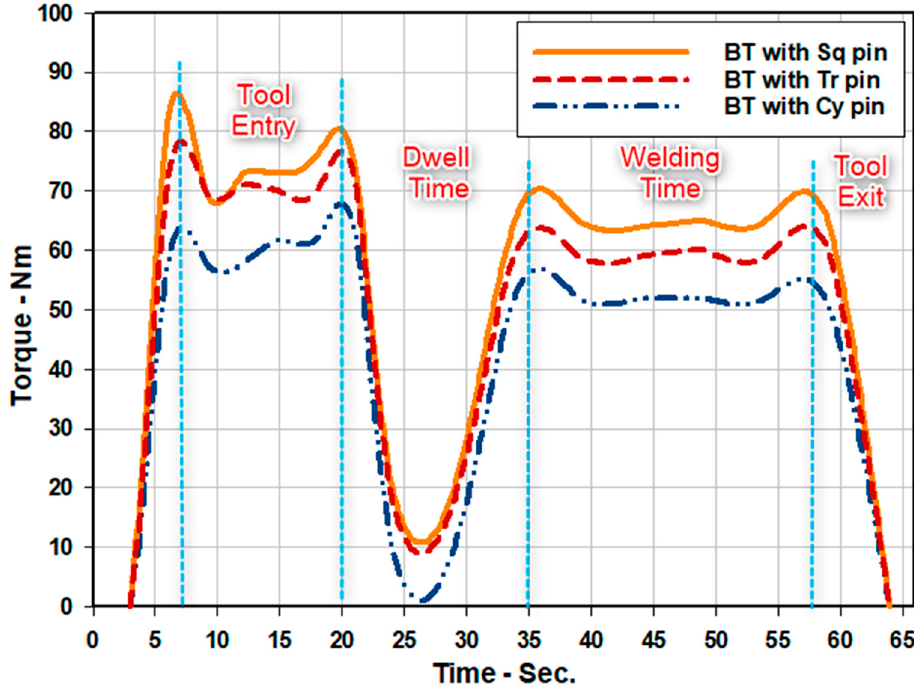
Figure 9. Torque during BT-FSW with different pins at 200 mm/min and 600 rpm.